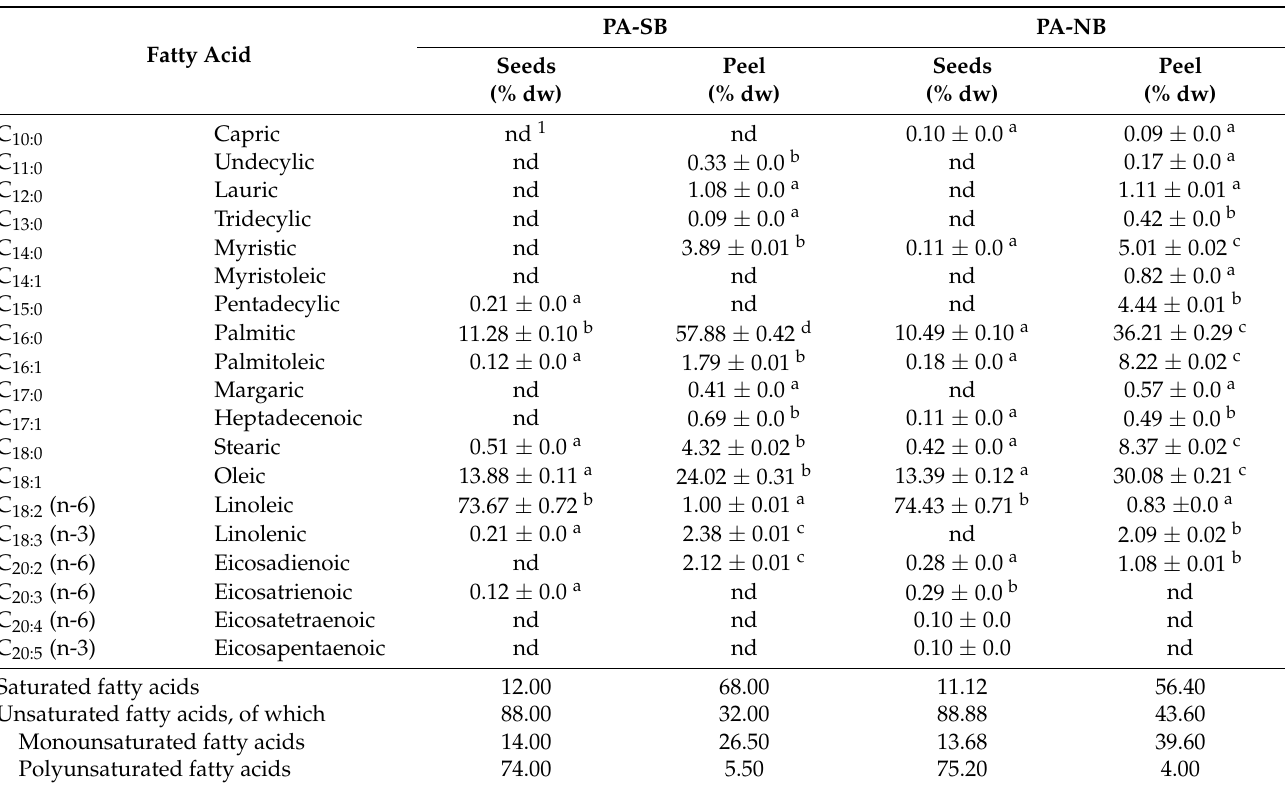
Table 3. Fatty acid composition of seed and peel oils of two P. alkekengi phenotypes (PA-SB and